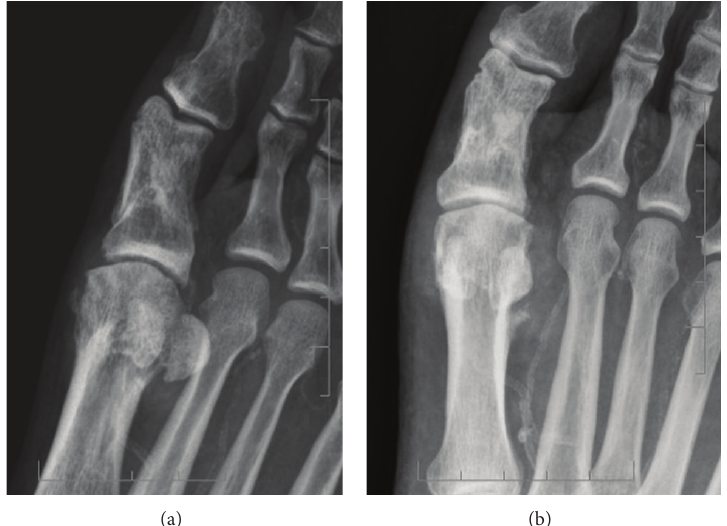
Figure 2: Initial radiographs show focal soft tissue reaction around the first MTP joint (emphasized by softer image windowing on (b)) without signs of bone affection. Healed fracture of the proximal first